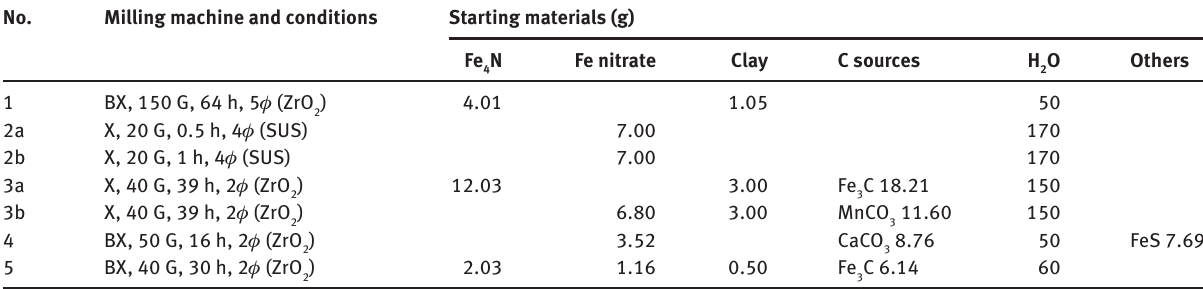
Table 1: Experimental conditions and starting materials.